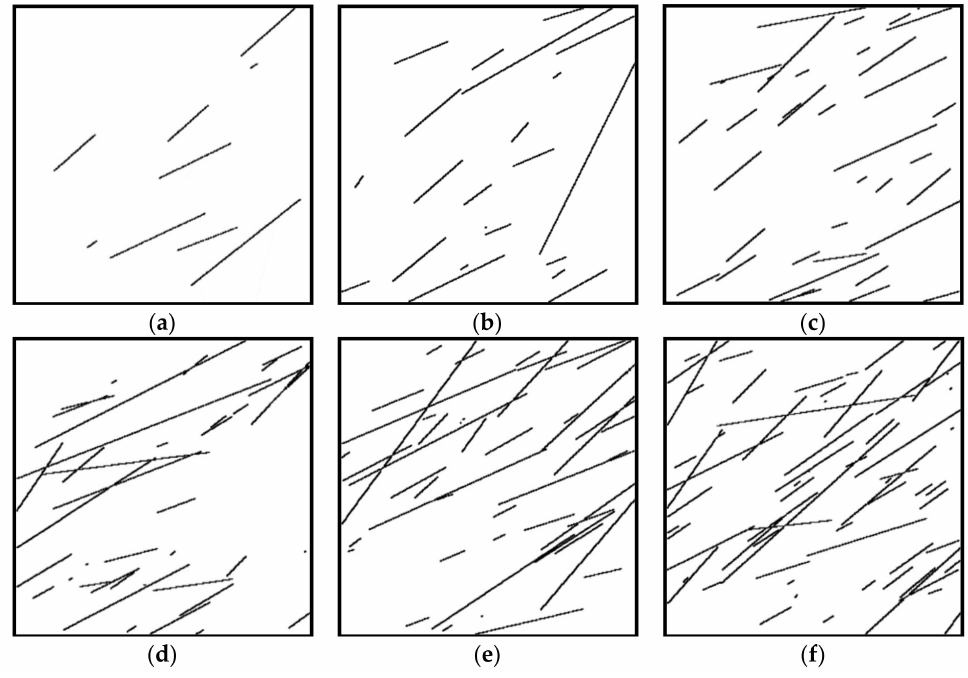
Figure 8. Fracture models with different density: ( a ) D s = 0.01, ( b ) D s = 0.02, ( c ) D s = 0.03, ( d ) D s = 0.04, ( e ) D s = 0.05, ( f ) D s = 0.06. The width and length of each model have 1000 pixels. The left side is the entrance and the right side is the exit. In the lattice Boltzmann simulation, all the parameters are dimensionless. The pressure (density) boundary condition [35] is adopted on both sides, while the standard bounceback boundary condition is applied to the other two boundaries. The pressure drop ( ∆ p ) between the entrance and the exit is 0.05 (lattice